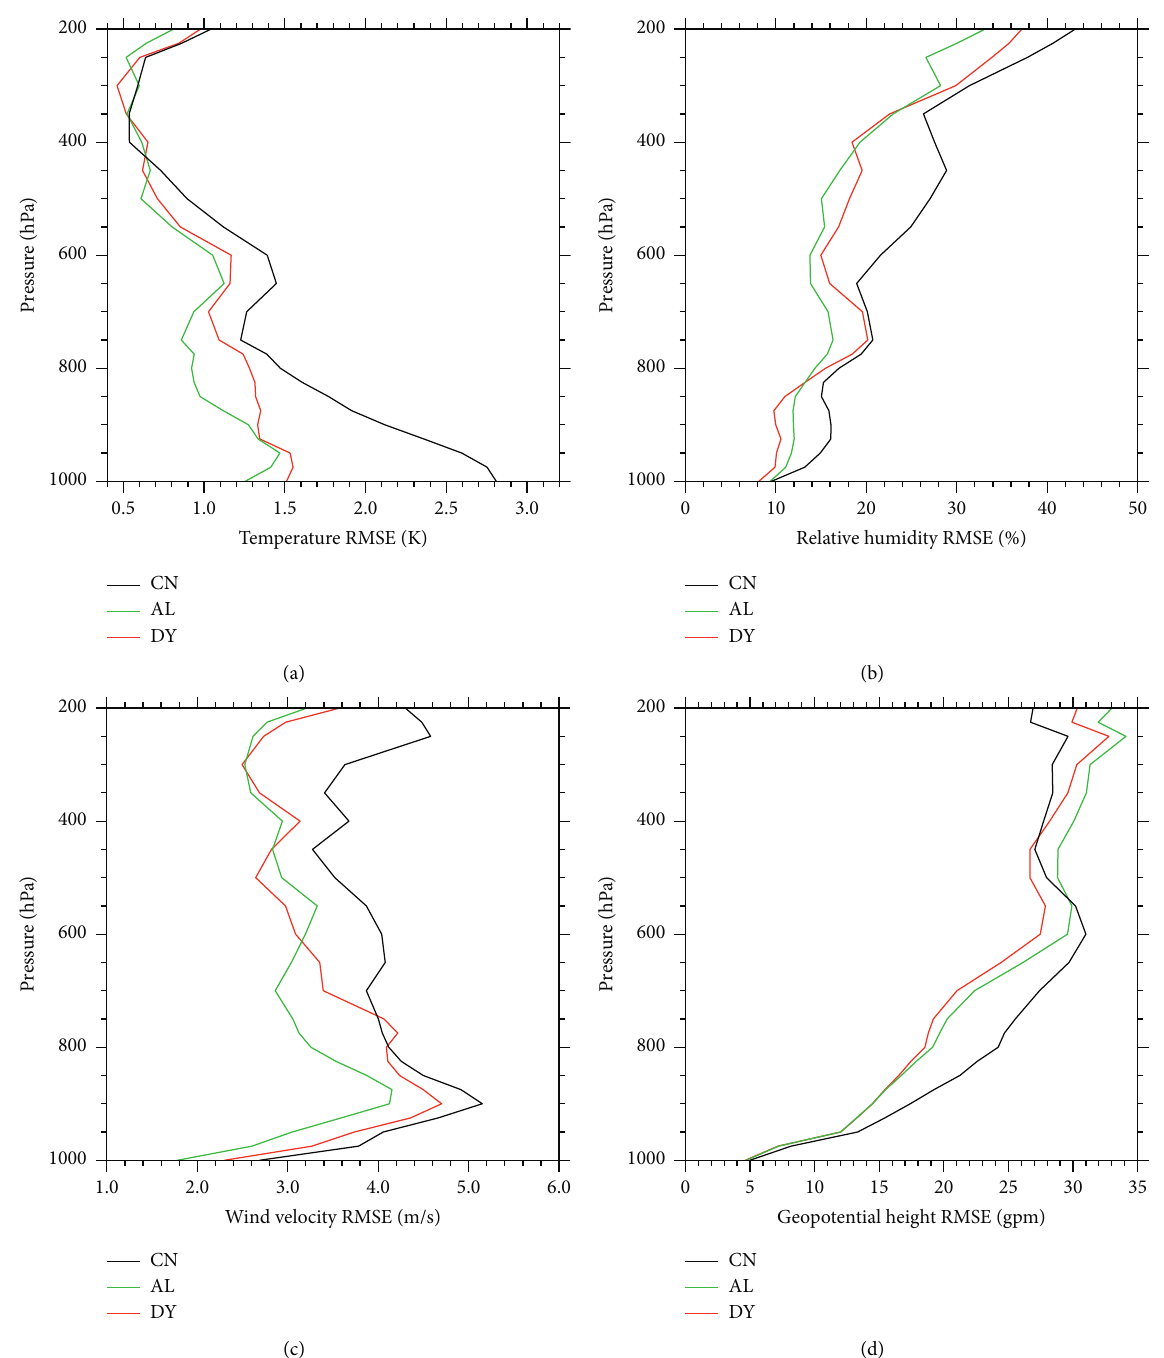
Figure 9: The vertical profiles of the 24-hour forecast RMSEs from 0000 UTC 24 June to 0000 UTC 25 June 2016 referring to the ERA-5 analysis of the temperature (a) (unit: K), relative humidity (b) (unit: %), wind velocity (c) (unit: m/s), and geopotential height (d) (unit: gpm) fields from the CN (black line), AL (green line), and DY (red line) experiments. The calculation area is the Yangtze River displayed in Figure 6(a) with a red-dashed line